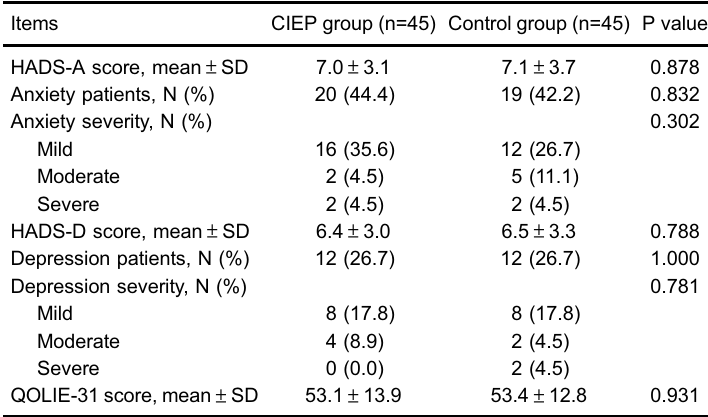
Table 3. Anxiety, depression, and quality of life at baseline (M0).